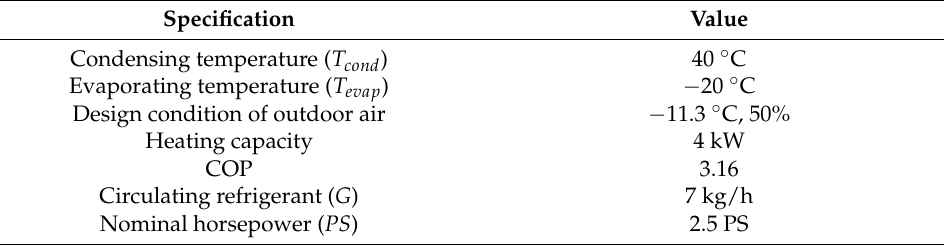
Table 2. Specifications of the heat pump selected. COP: coefficient of performance.